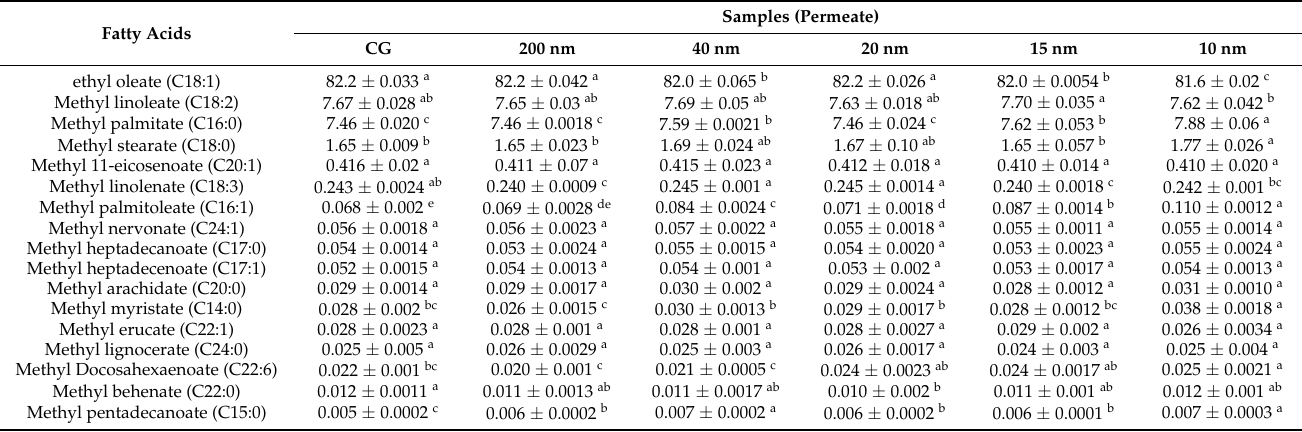
Table 2. Fatty acid composition analysis